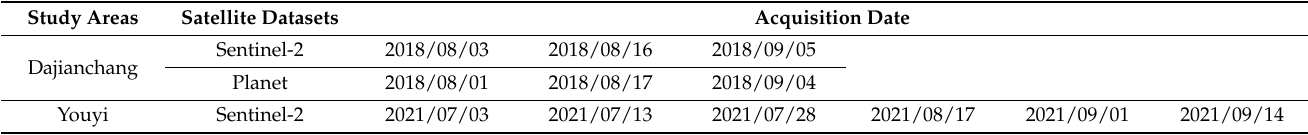
Table 3. Sentinel-2 and Planet images acquired of the two study